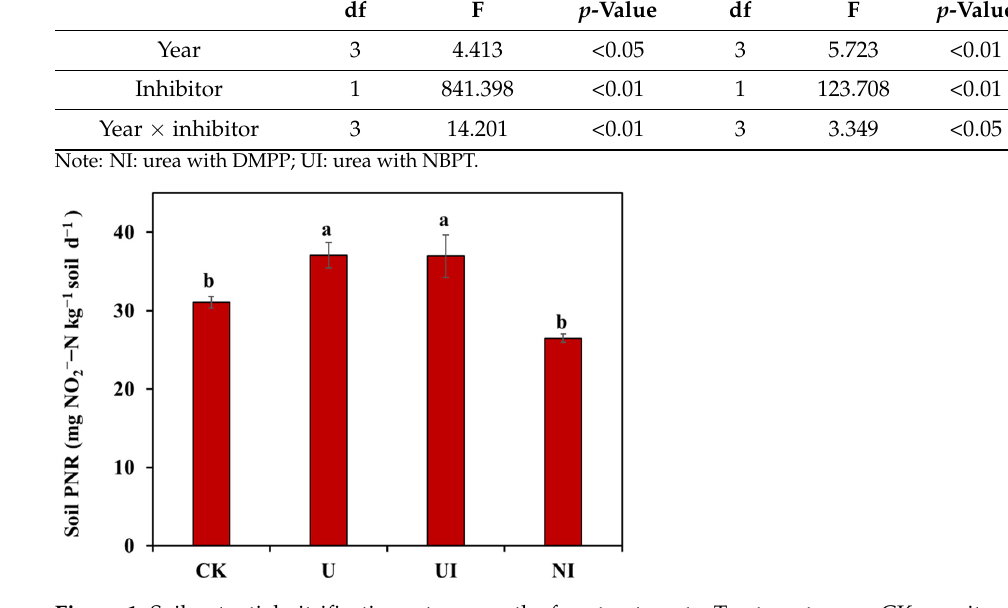
Figure 1. Soil potential nitrification rate across the four treatments. Treatments were CK: no nitrogen fertilizer application; U: urea; UI: urea with 0.4% NBPT; and NI: urea with 1% DMPP. Error bars represent standard errors of. Different lower cases indicate significant differences among treat- ments. Table 1. Annual cumulative N 2 O emission factors of applied N treatments; N 2 O mitigation of DMPP and NBPT.